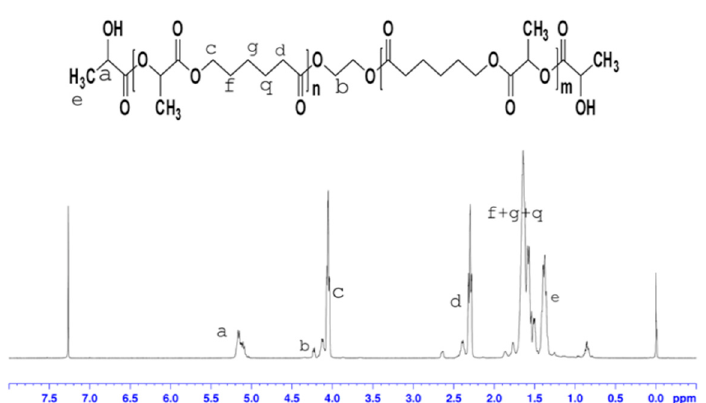
Figure 6. 1 H-NMR spectrum of the poly(LA-CL) copolymer with glycol.